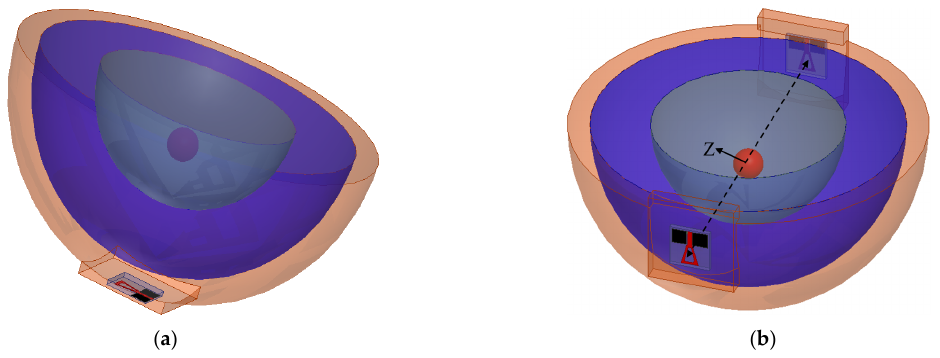
Figure 11. The phase of reflection coefficient and axial ratio are also recorded and tracked for changes due to the presence of tumors in the simulated breast models,as shown later in the next paragraph. The phase of reflection of the coefficient phase is shifted by 50° due to the varying size of the tumor, as presented in Figure 11b.